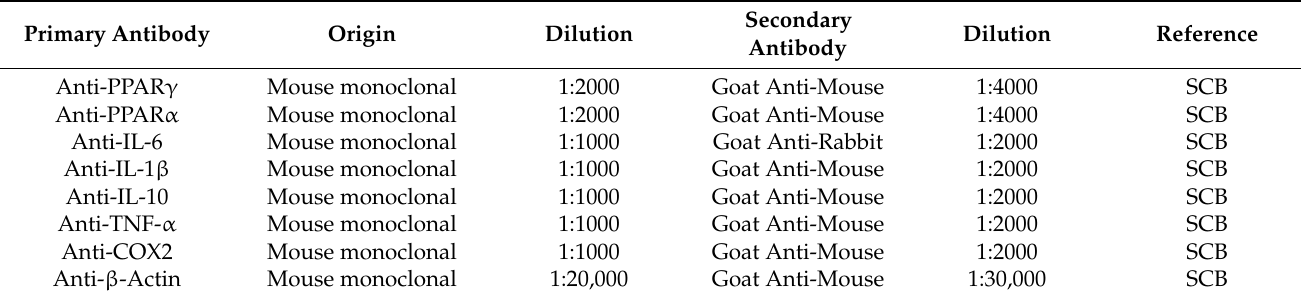
Table 1. Antibodies used for Western blotting analysis. SCB = Santa Cruz Biotechnology (Santa Cruz, CA, USA).